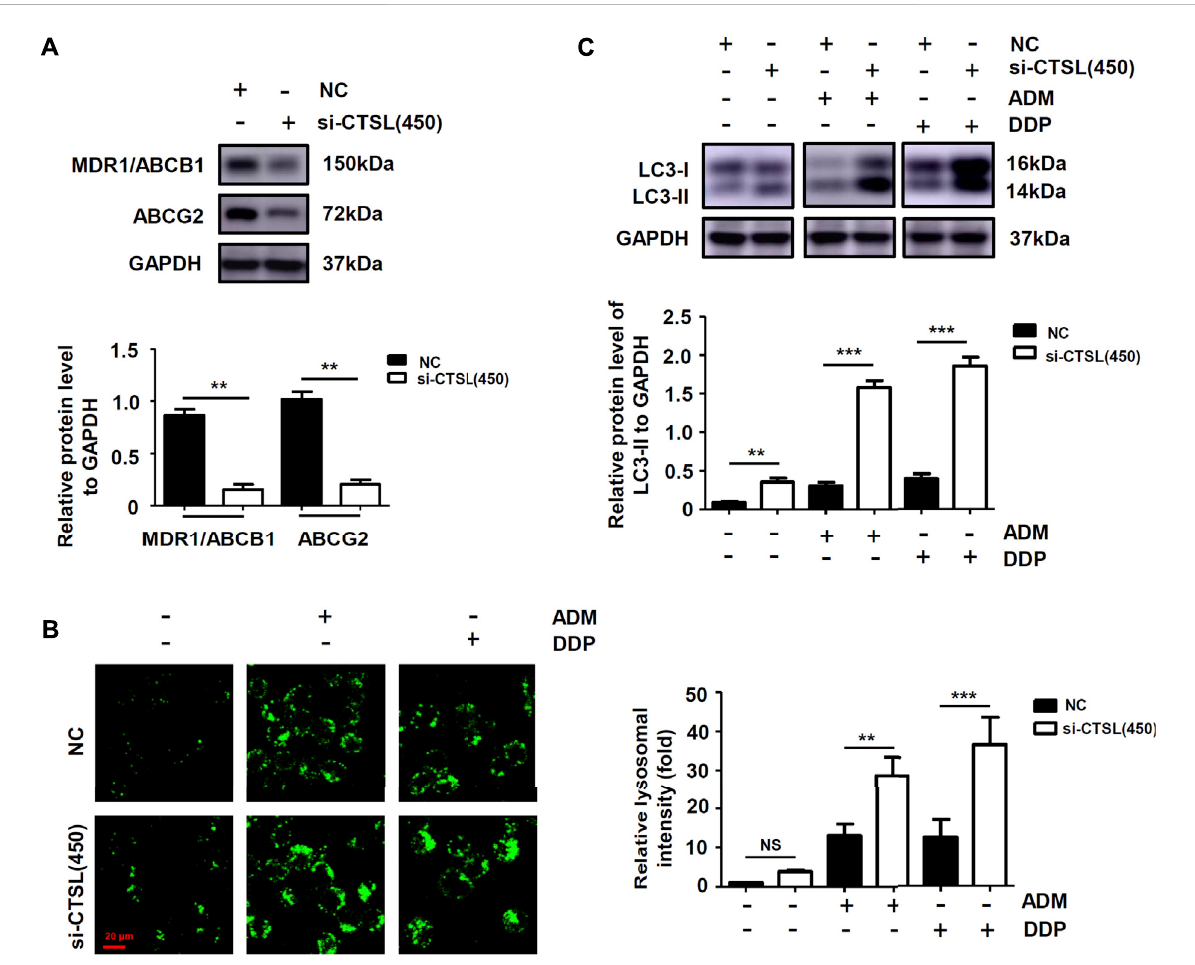
FIGURE 4 Theexpressionofmulti-drugresistanceproteinsandautophagylevelofNBcellsafterknockdownofCTSL (A) Westernblotshowingmulti-drug resistanceproteinsexpressioninSK-N-BE(2)cellsafterCTSLsilencing (B) Lysosomestainingassayshowingthequantityandintracellularlocationof lysosome in SK-N-BE (2) cells with different treatments (red bar: 20 μ m) (C) The expression of LC3-I and LC3-II in SK-N-BE (2) cells were analyzed using Western blot. NS: not statistically signi fi cant, **, p < 0.01, ***, p <